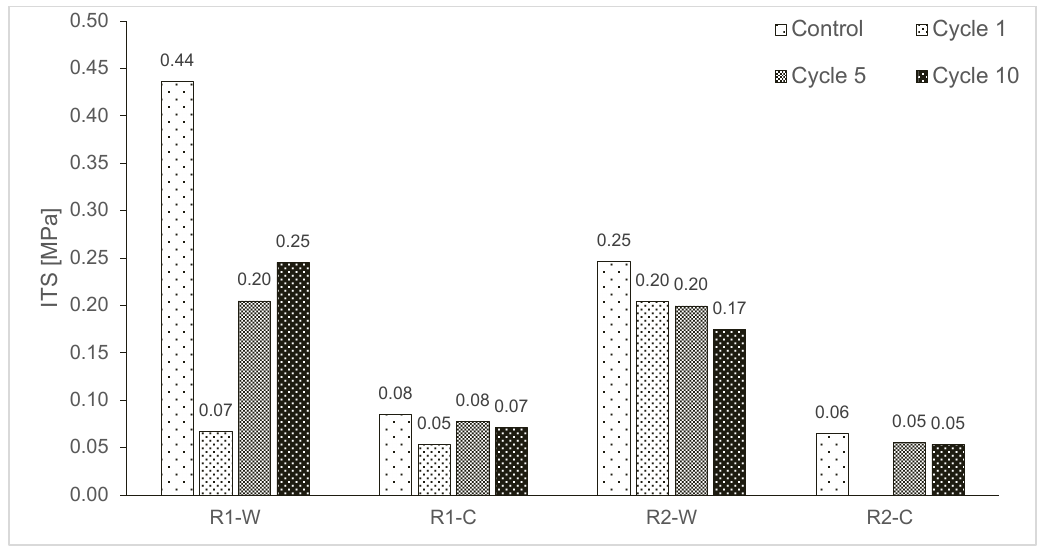
Figure 8. ITS values for tests carried out at 5 °C and different cycles.